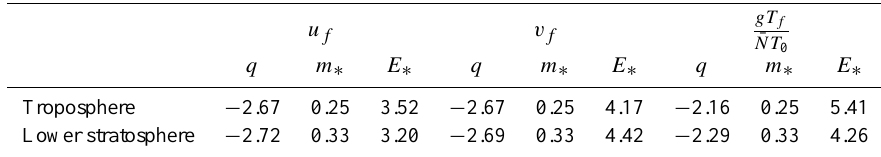
Fig. 5. Averaged vertical wave number spectra (solid curves) for the zonal kinetic energy density (left column), meridional kinetic energy density (middle column) and potential energy density (right column) in the troposphere (bottom row) and lower stratosphere (top row) in August 2006. The dashed lines denote the fitted spectra. The theoretical saturation limits of Smith et al. (1987) are also plotted for comparison purposes (dash-dotted lines). Table 2. Parameters of vertical wavenumber spectra for GWs in the troposphere and lower stratosphere over Yichang station in Au- gust 2006. q represents the slope of the vertical wavenumber spectrum in the large wavenumber regions. m ∗ (in (Cycle/km)) and E ∗ (in m 2 s 2 /(Cycle/km)) denote the characteristic vertical wavenumber and the corresponding spectral